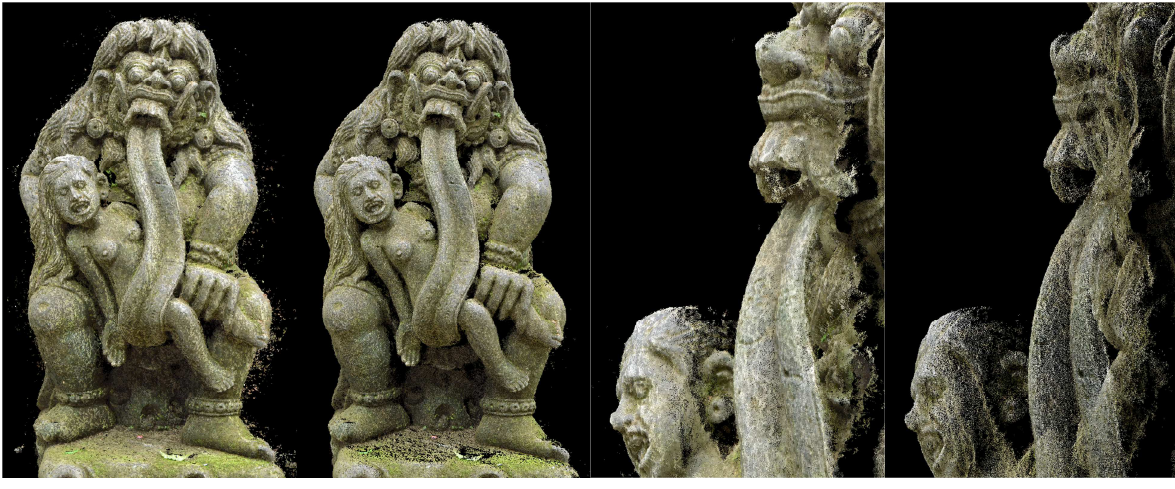
Fig. 1: Troll. 9 images with 4 MP each . Fold: 2. Pointcount: 15.2 Mio. before, 2.3 Mio. after filtering. Time: 40s